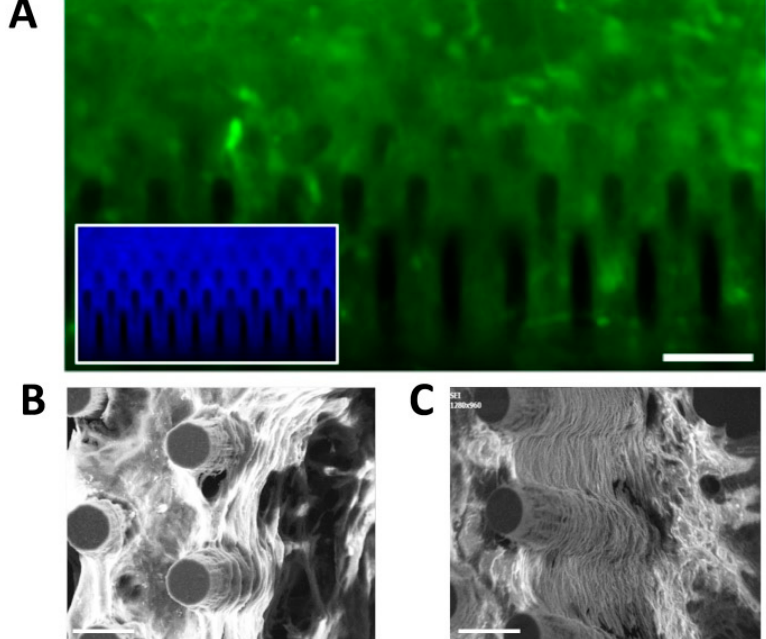
Figure 6. hCPs cultured on silicon micropillar arrays establish layered structures. ( A ) Picture of eGFP + ve hCPs cultured for 14 days on silicon slides showing the establishment of a high-density 3D culture. Inset shows the same culture stained with Hoechst. ( B , C ) SEM images of hCPs maintained on silicon pillars device for 14 days. Cultures exhibit the generation of multiple cell layers. Scale bar: 50 µm ( A ) and 20 µm ( B , C ).